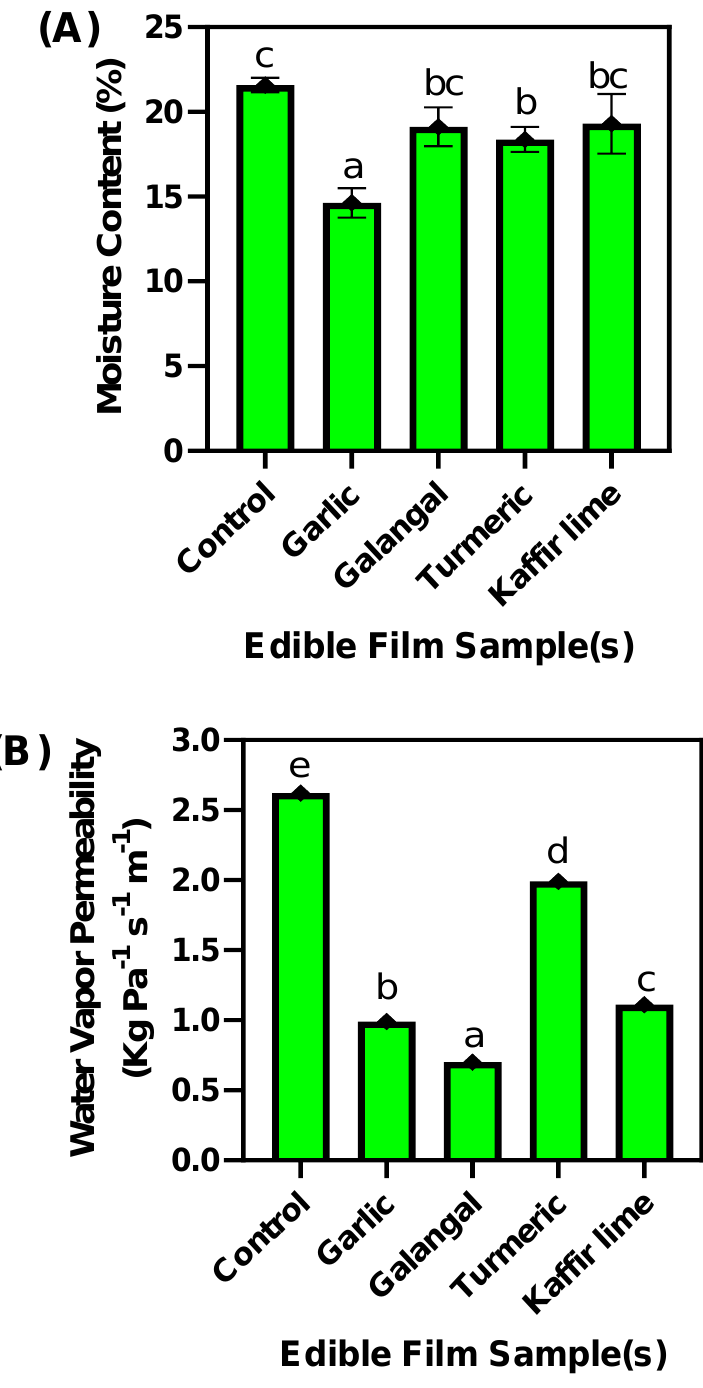
Figure 4. Moisture content ( A ) and water vapor permeability ( B ) of chitosan–NGRS based edible film incorporated with and without EOs. Note: The different letters shown in the figure represents significant